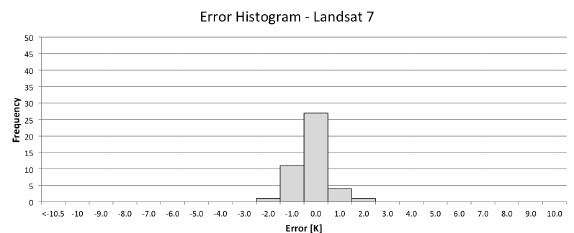
Figure 8: Histogram of error values for small subset of cloud free Landsat 7 scenes.